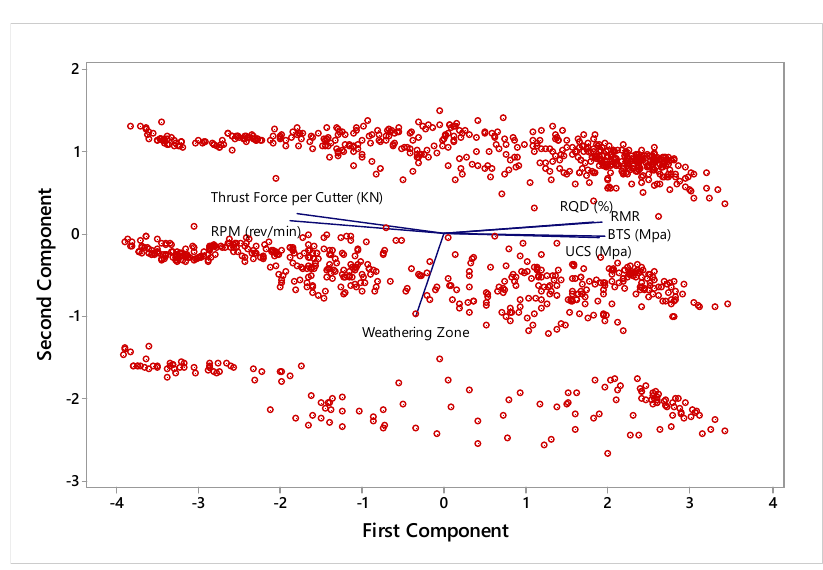
Figure 4. Density diagram of the input parameters using PCA. Table 3. Eigen Analysis correlation matrix for establishing input variables by PCA.